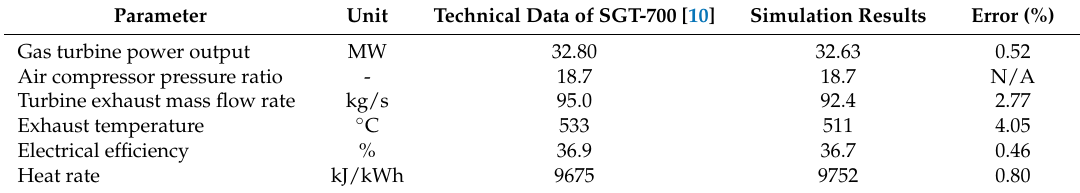
Table 6. Comparison of technical data and simulation results for gas turbine simple cycle.